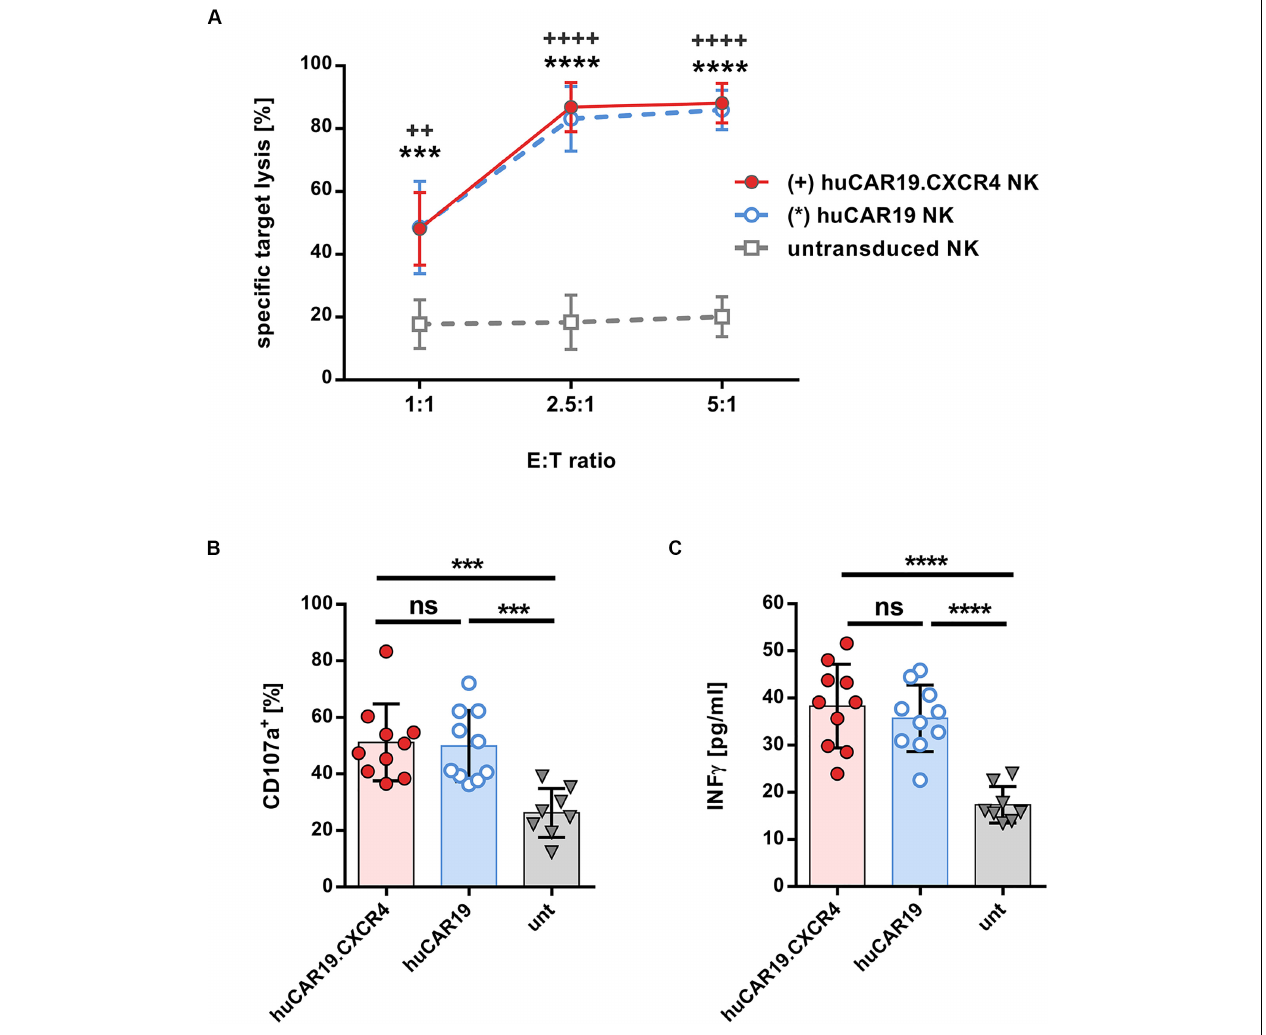
FIGURE 3 | Functional characteristics of gene-modified CAR NK cells. Analysis of cytotoxic function, degranulation, and IFN γ secretion of huCAR19 or huCAR19.CXCR4 gene-modified primary NK cells upon cocultivation with CD19-positive Nalm-6 cells. Untransduced primary NK cells cultured in parallel were used as a control. CAR NK cells were generated by transduction of primary NK cells with huCAR19-LV or huCAR19.CXCR4-LV particles at an MOI of 1–5. (A) Flow cytometry-based killing assay. After determination of huCAR19 expression, CAR NK cells as well as untransduced primary NK cells were mixed with CFSE-labeled Nalm-6 cells in different effector-to-target (E:T) ratios as indicated. The percentage of dead target cells were identified as double positive cells for CFSE and viability dye by flow cytometry. Mean values, SDs, and significance are shown. n = 7 with technical replicates. Unpaired t test was performed to determine significance comparing CAR NK cells ( ∗ for huCAR19.NK cells; + for huCAR19.CXCR4 NK cells) versus untransduced samples. ++ p < 0.005; ∗∗∗ p < 0.001; and ∗∗∗∗ , ++++ p < 0.0001. (B,C) Degranulation (B) and IFN γ secretion assay (C) . Transduced as well as untransduced primary NK cells were mixed with Nalm-6 cells at an E:T ratio of 1. In the first hour of coculture FITC conjugated anti-CD107a antibody was added. After 4 h, cells and supernatant were collected. Harvested cells were used to determine CD107a expression by flow cytometry (B) . IFN γ secretion was determined in the supernatant by ELISA (C) . Bar diagrams show individual results as well as mean values, SDs, and significance. n = 5 with technical replicates. ∗∗∗ p < 0.001; ∗∗∗∗ p < 0.0001; ns, non-significant by unpaired t